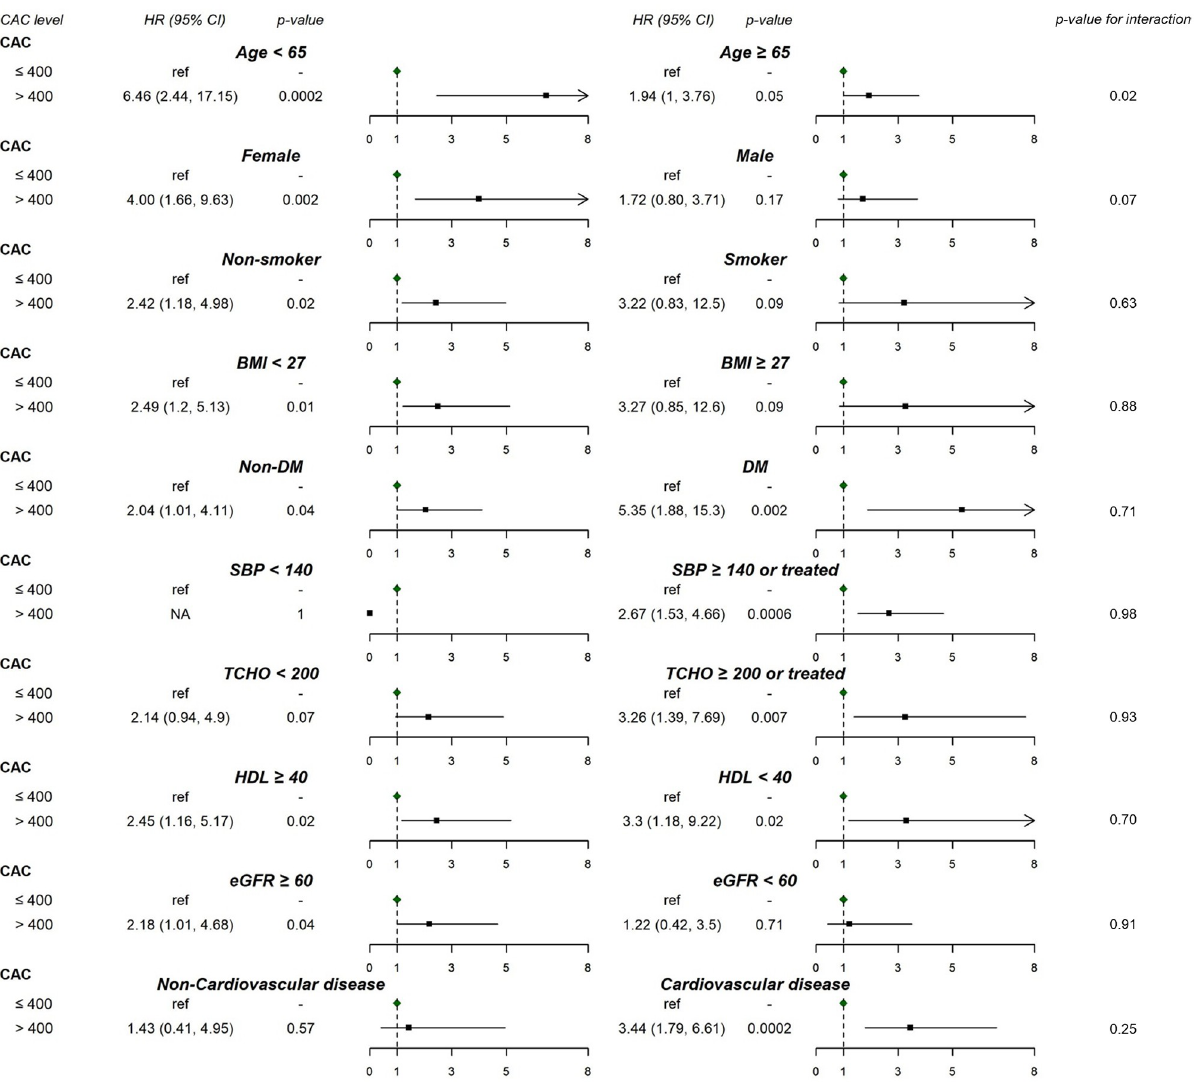
Fig 2. Multivariable HRs (95% CIs) of mortality risks according to CAC stratified by other variables. BMI, body mass index; CAC, coronary artery calcium; DM, diabetes mellitus; SBP, systolic blood pressure; TCHO, total cholesterol; HDL, high-density lipoprotein; eGFR, estimated glomerular filtration